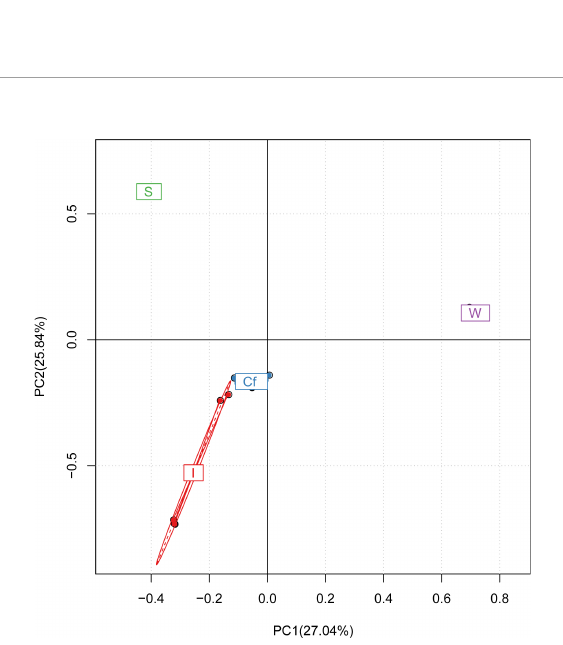
FIGURE 6 Principal component analysis of different samples (The closer the samples are, the more similar the composition of the